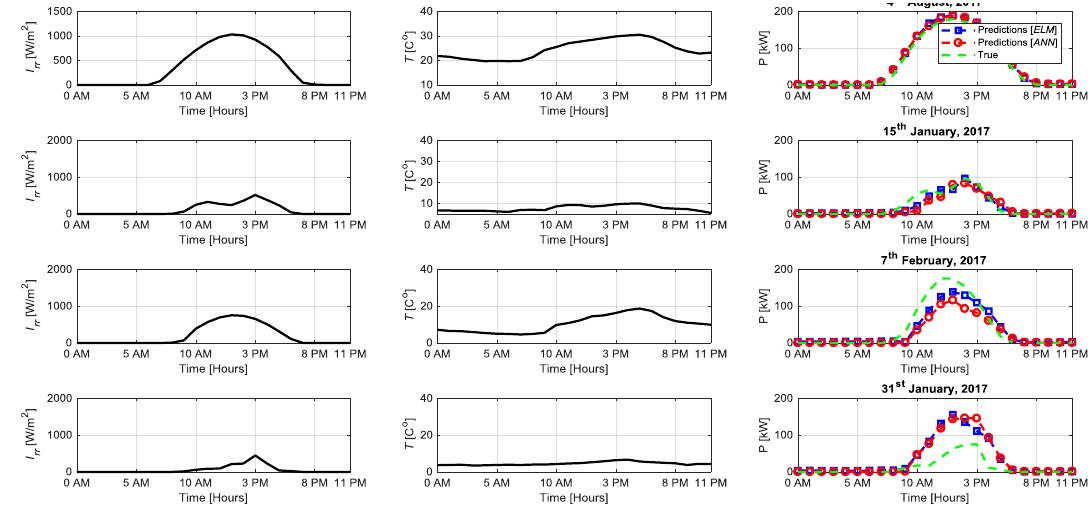
Figure 8. Global solar radiations ( left ), temperatures ( middle ), and the associated power production predictions ( right ) obtained by the developed ANN model with respect to those obtained by the proposed ELM model for four different days in 2017.